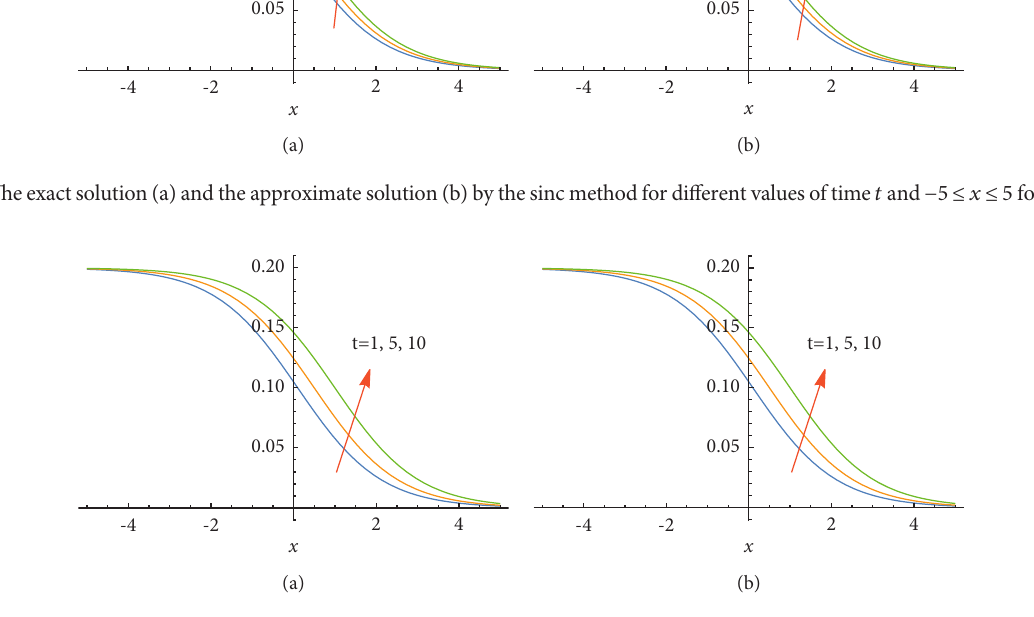
Figure 3: The exact solution (a) and the approximate solution (b) by the sinc method for different values of time t and − 5 ≤ x ≤ 5 for Example 1.